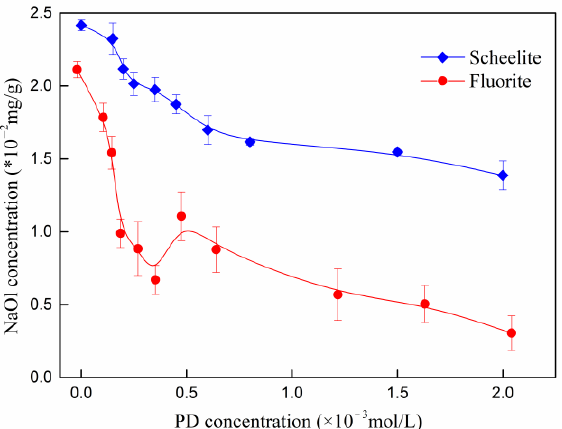
Figure 5. NaOl adsorption by scheelite and fluorite as a function of the PD concentration when pH = 9.